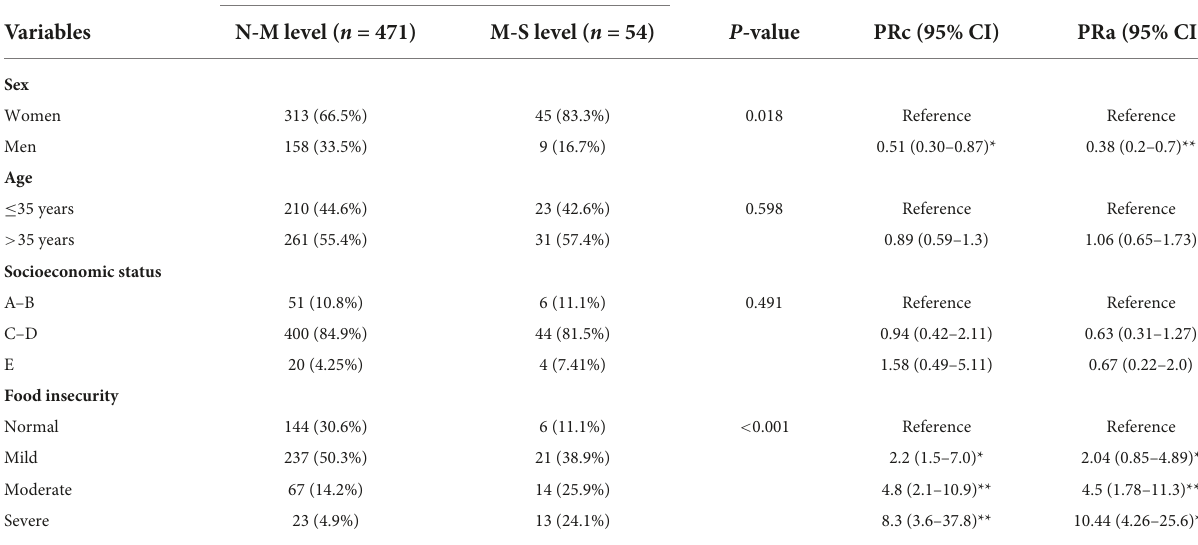
TABLE 2 Association between level of food insecurity and